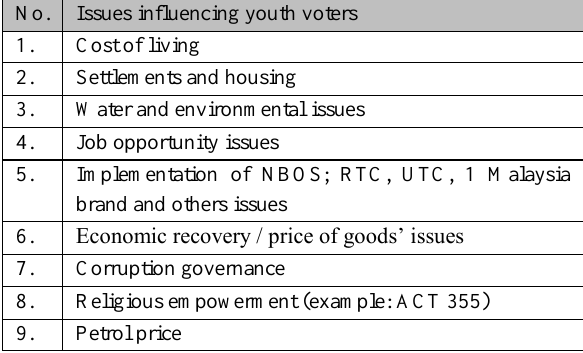
Table 2. Issues influencing youth voters in Nusajaya